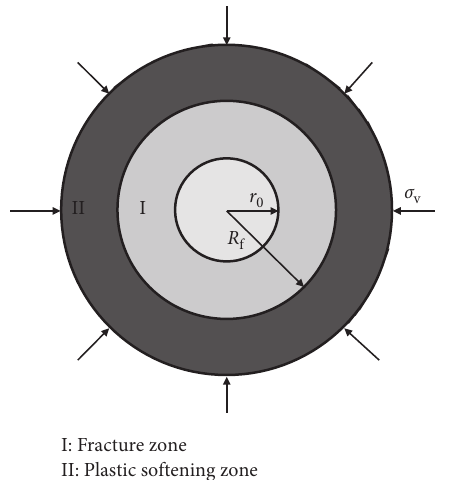
Figure 2: Mechanical model for plane strain surrounding the drilling hole in the plastic